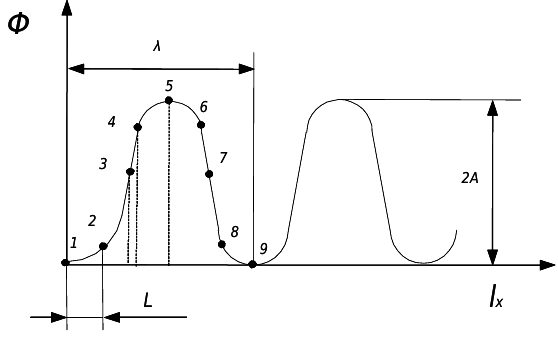
Fig 2. A simplified diagram of error distribution In the simplified diagram of error distribution (Fig 2) the pitch of discretization of coordinate measurement is indicated by L and by λ – a wavelength of its